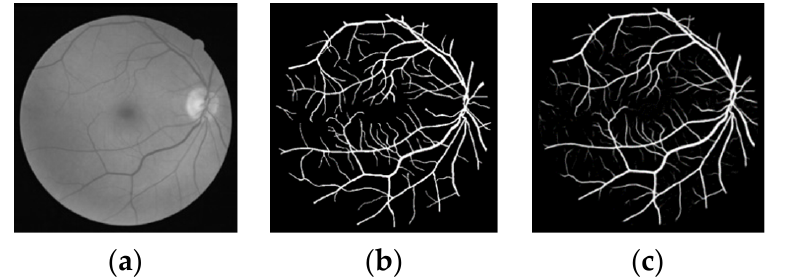
Figure 7. Second group of segmentation results ( a ) original image ( b ) gold standard image ( c ) seg- mentation results of this paper.